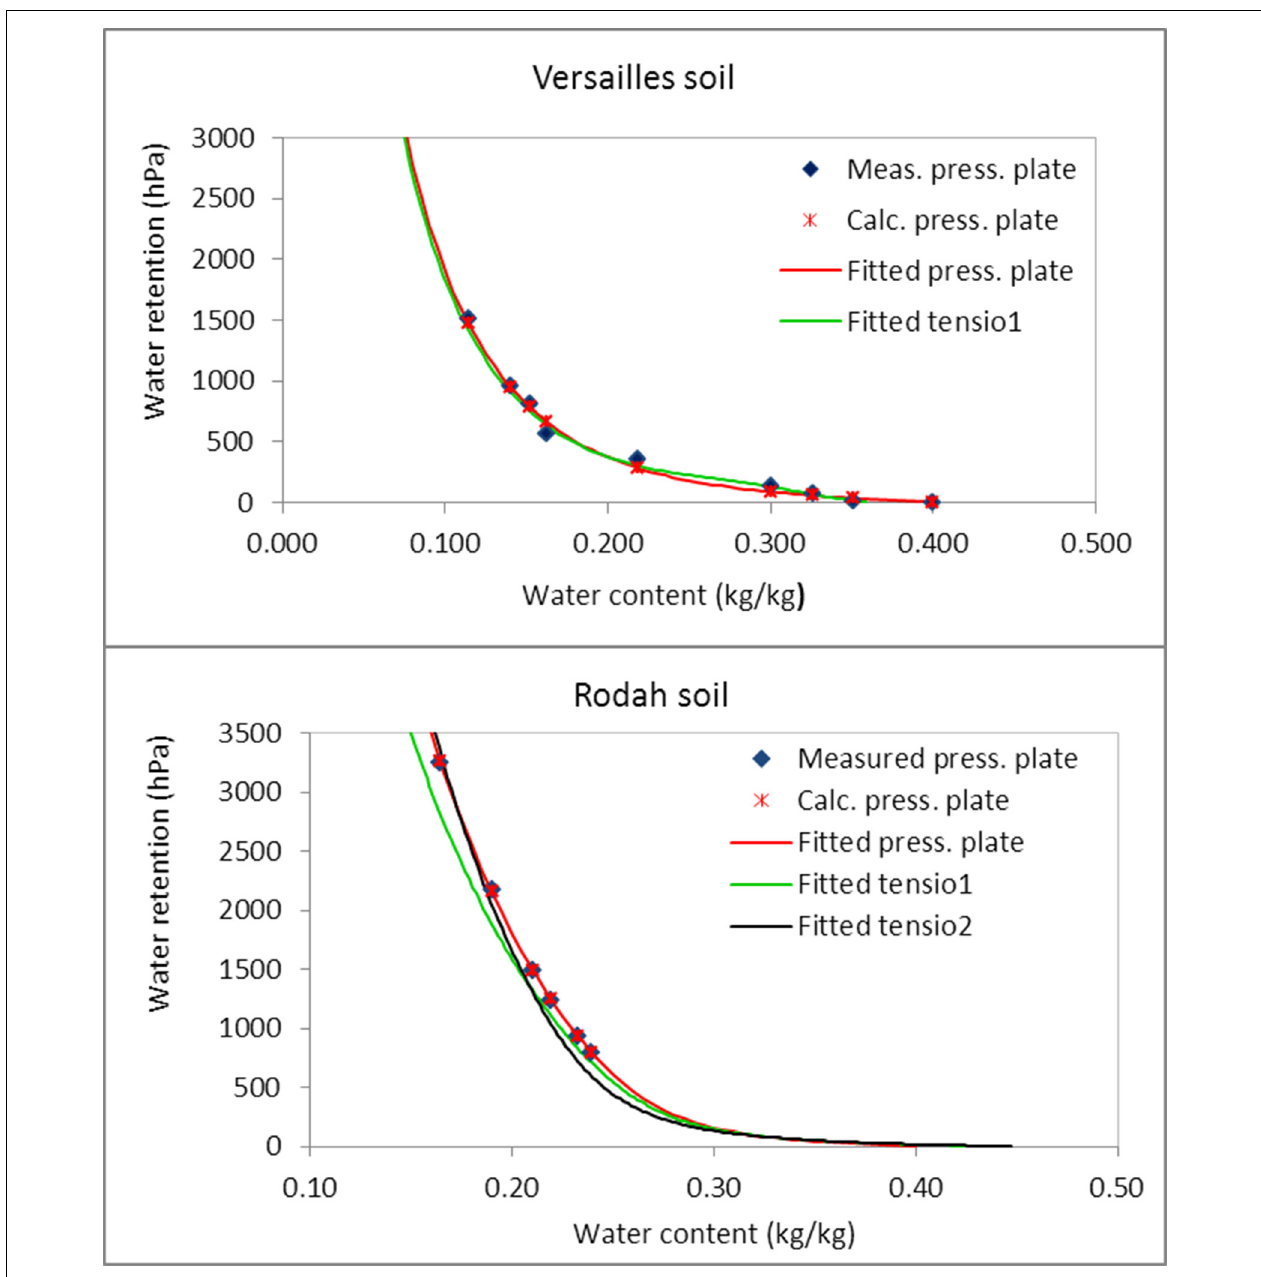
FIGURE 2 | Three water retention curves for each soil. (i) Measured (dark-blue points) using the pressure plate apparatus, (ii) Fitted (red line and crosses) on these measured points using the